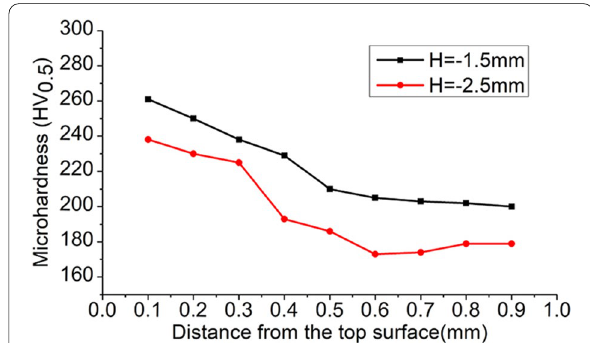
Figure 24 Hardness distribution along clad thickness at H 1.5 mm and H 2.5 mm = − = −